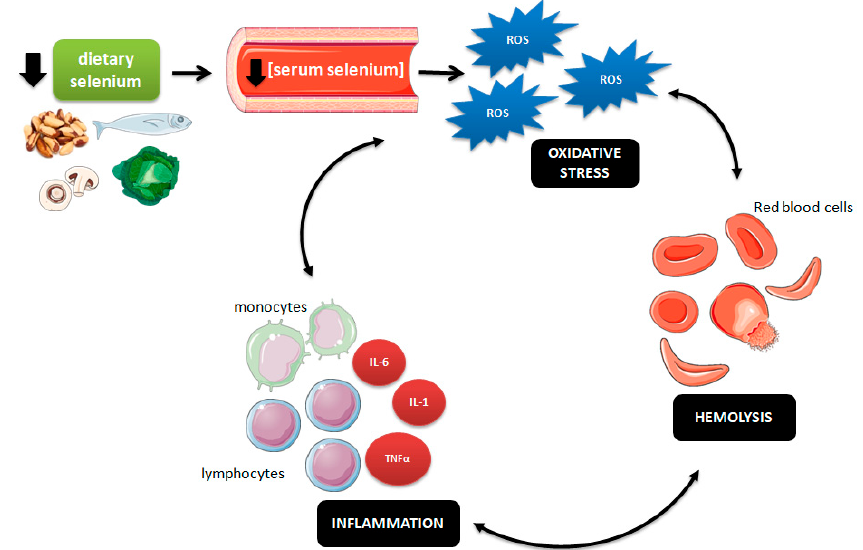
Figure 2. Representative scheme of the relationship between low dietary selenium intake, serum selenium concentration, and the oxidative–hemolysis–inflammation cycle in sickle cell disease (SCD) patients. ROS (reactive oxygen species), IL-1 (interleukin 1), IL-6 (interleukin 6), TNF α (tumor necrosis factor α ).